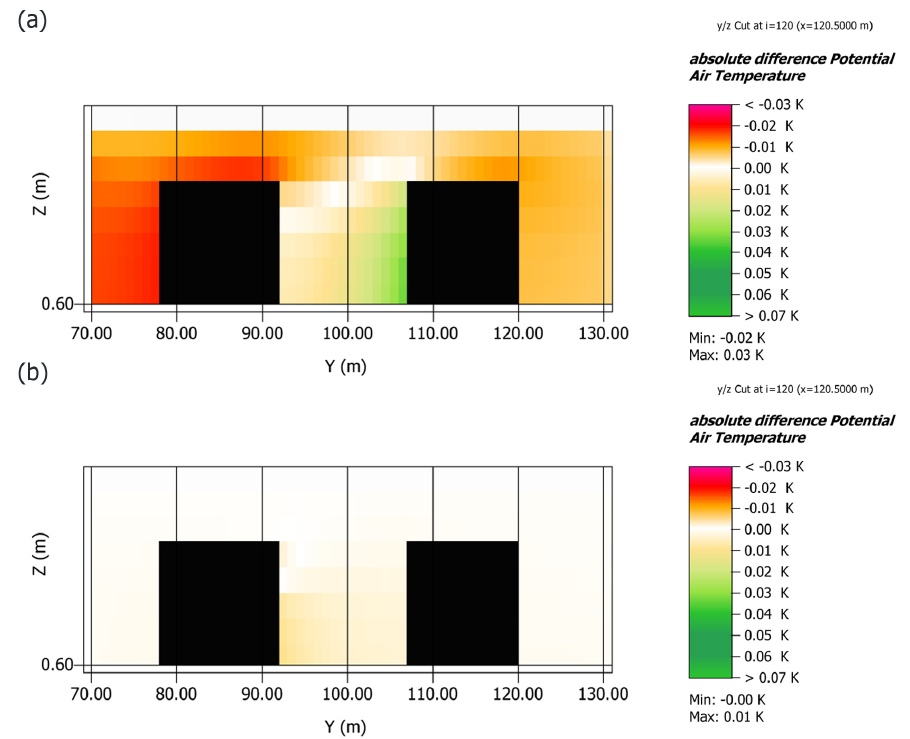
Figure 11. The difference of air temperature between absolute current state and the reference state of green wall on the southern (a) and northern (b) plane; view in west direction. Figure by authors.